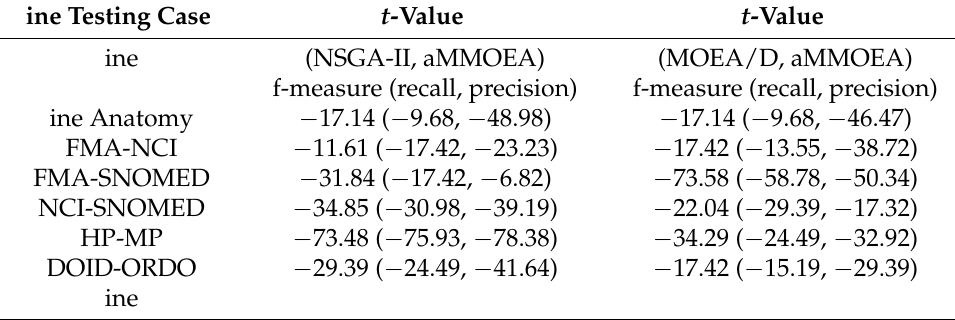
Table 4. t -Test’s t -value on the alignment’s quality.